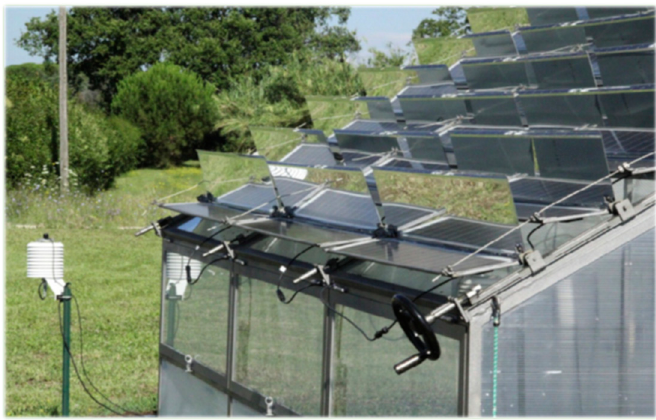
Figure 3. Greenhouse with mobile panels [65].